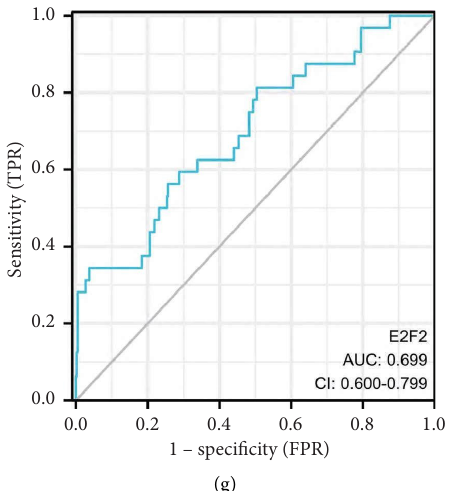
Figure 8: (a) Te OS between high- and low-expression of E2F2 groups; (b) the DSS between high- and low-expression of E2F2 groups; (c) the PFI between high- and low-expression of E2F2 groups; (d) the immune checkpoint-related genes between high- and low-expression of E2F2 groups; (e) the immune cell infltration between high- and low-expression of E2F2 groups; (f) the TIDE score between high- and low- expression of E2F2 groups; (g) the ROC curve shows the predictive value of E2F2 in TCGA GC